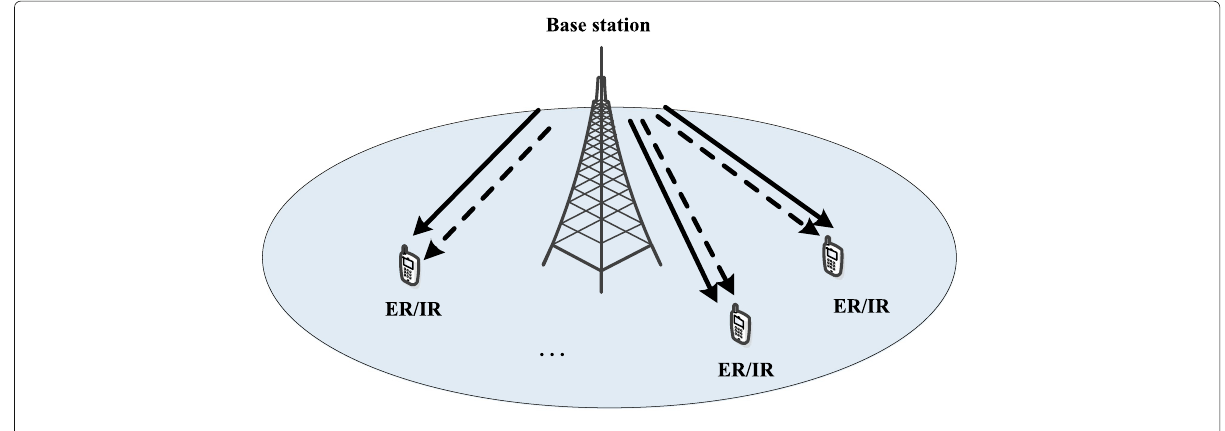
Fig. 1 MISO SWIPT system